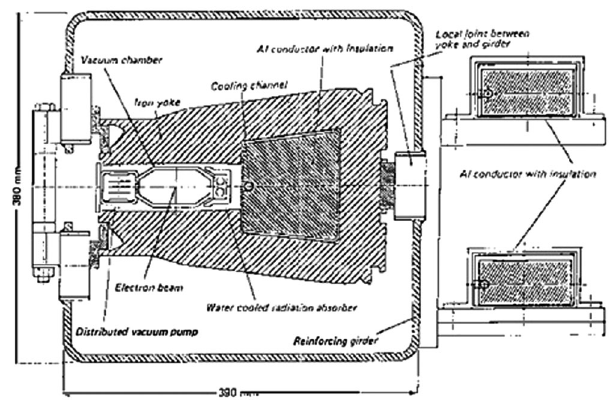
FIG. 2. Cross section of the HERA electron ring